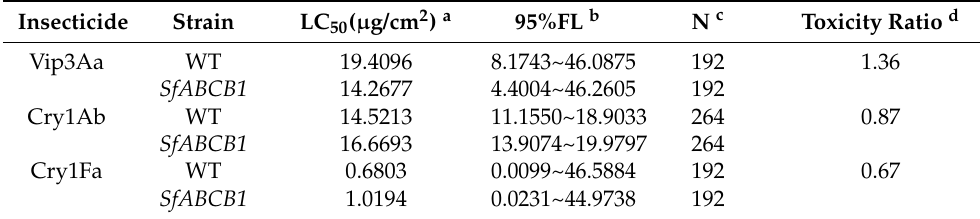
Table 2. Susceptibility of Spodoptera frugiperda neonates from ABCB1 knockout strain ( SfABCB1 ) and wild-type strain to 3 Bt